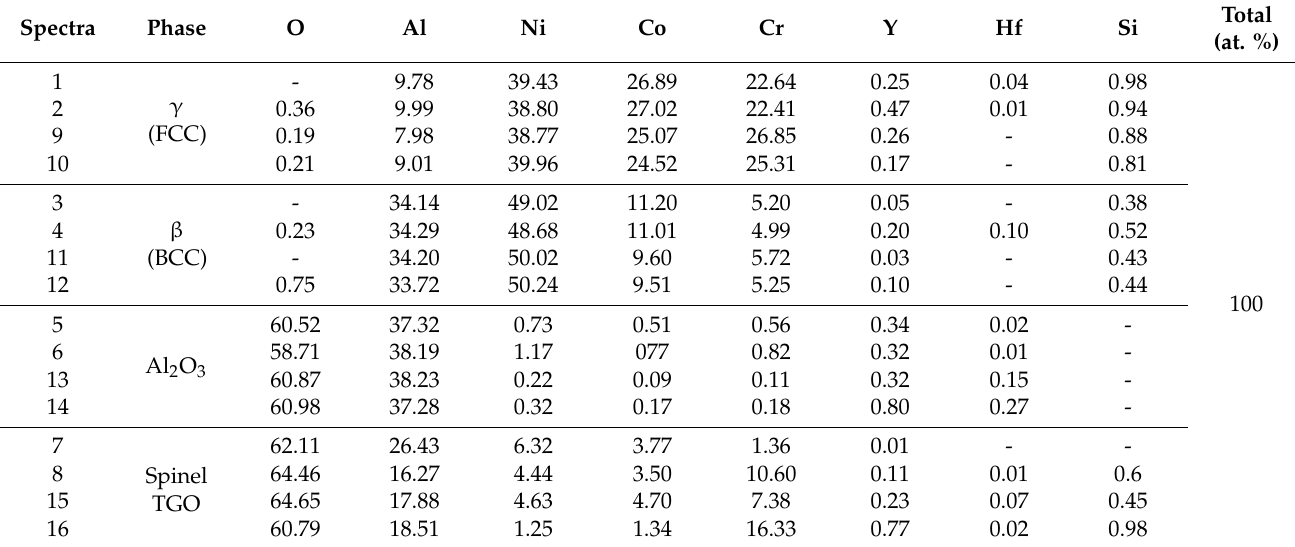
Table 3. Results of EDS analysis of the VPS bond coat shown in Figure